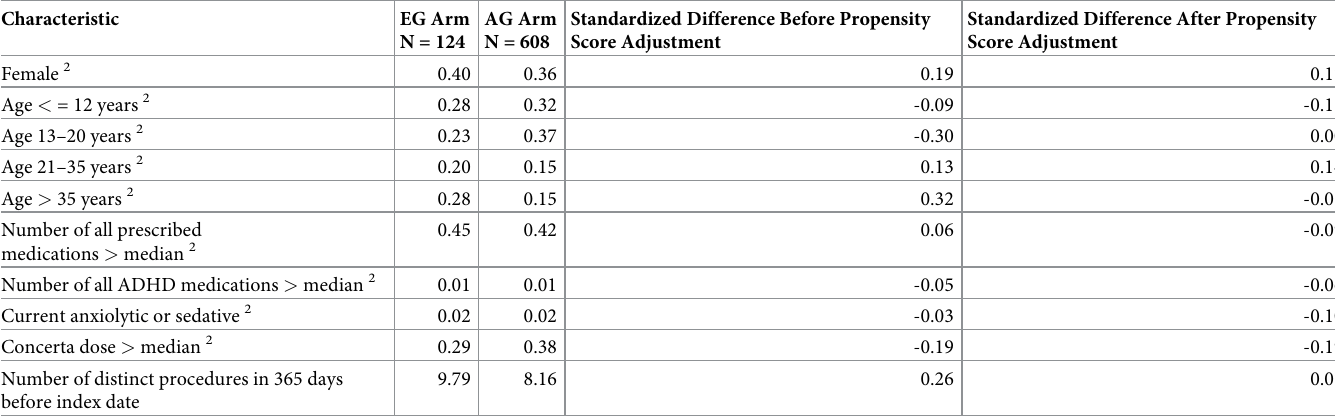
Table 3. Standardized differences before and after propensity score adjustment for selected characteristics of study subjects. 1